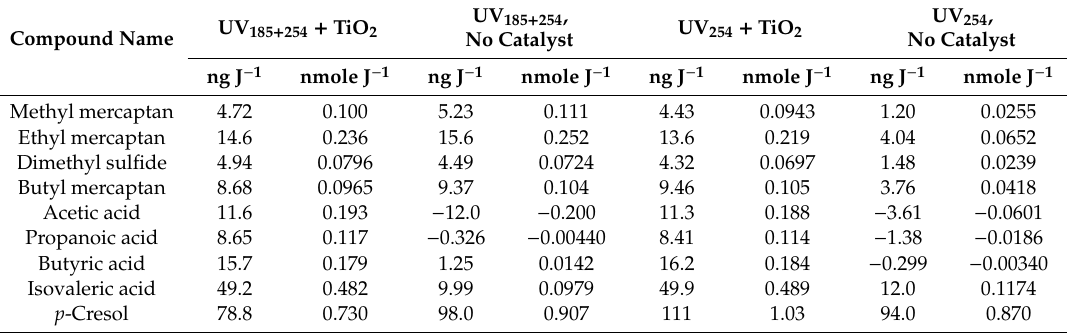
Table 2. Summary of mass removal rates per unit of input UV energy (ng J − 1 ; nmole J − 1 ).